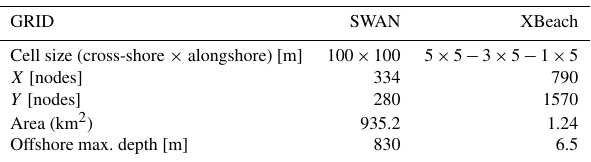
Figure 2. (a) Pre-storm detailed bathymetry; (b) post-storm detailed bathymetry; (c) pre- and post-storm beach profiles at Bocagrande (Cartagena de Indias). Table 2. SWAN and XBeach computational domain for Bocagrande Beach.